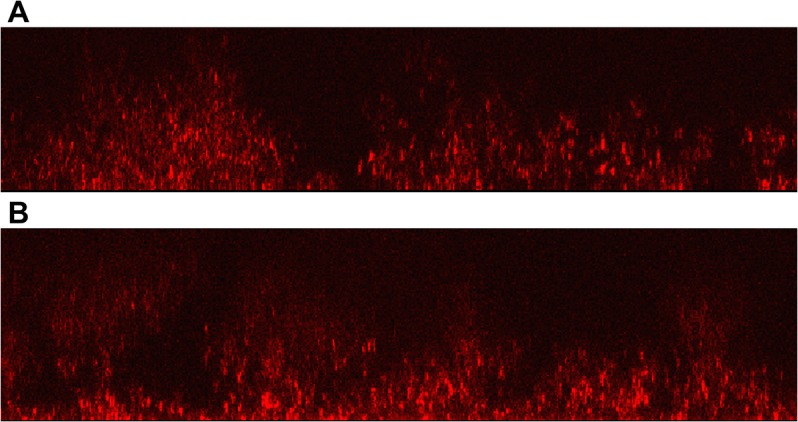
Confocal images of R. palustris biofilms growing under (A) heterotrophic and (B) photoheterotrophic conditions.Raw vertical images show characteristic morphologies observed in biofilms grown under either of the two growth conditions. Image dimensions are (145 μm x 30 μm) and (145 μm x 35 μm) respectively. The coverslip and light source direction are at the bottom of the images with media above. Biofilms formed under anaerobic and phototrophic conditions show a greater tendency toward ‘T’ or mushroom shaped structures.